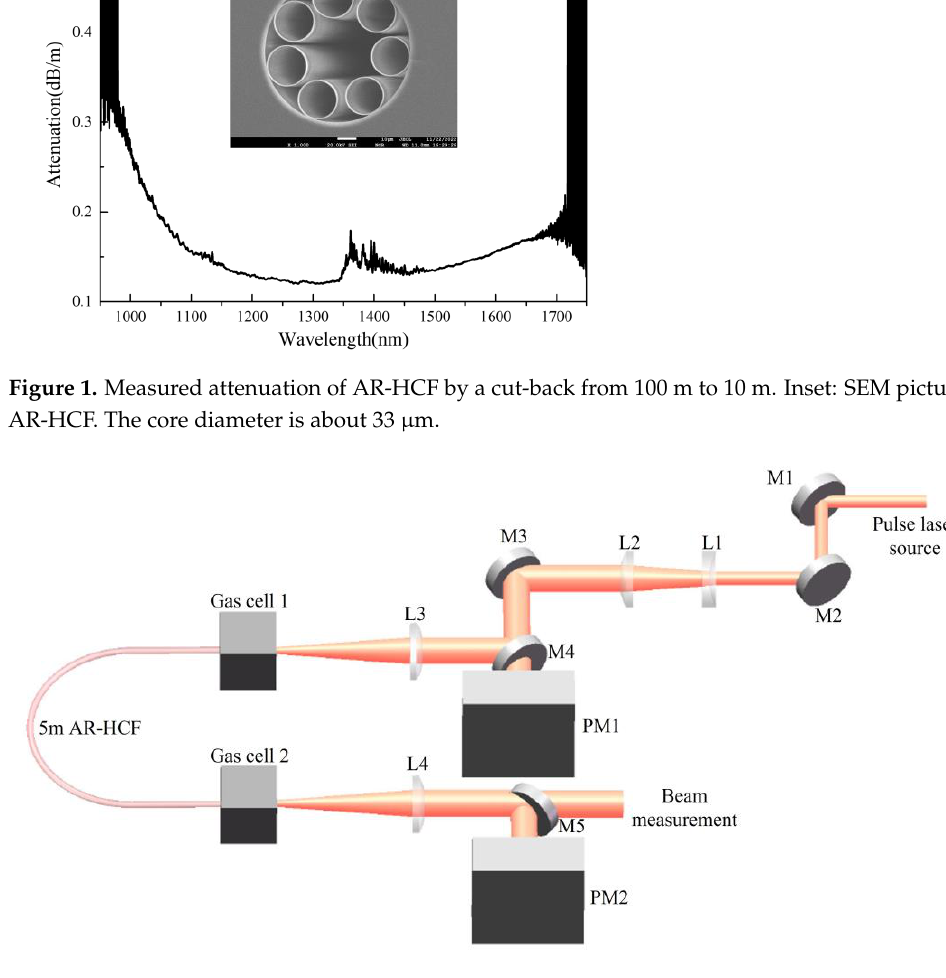
Figure 2. Schematic of the laser delivery setup: L1, L2, L3, L4 are coated spherical lenses; M1, M2, M3 are dielectric mirrors; M4, M5 are back polished mirrors used as a sampler. PM1, PM2 are power meters. The AR-HCF is mounted on a silica V groove loaded in a homemade gas cell.